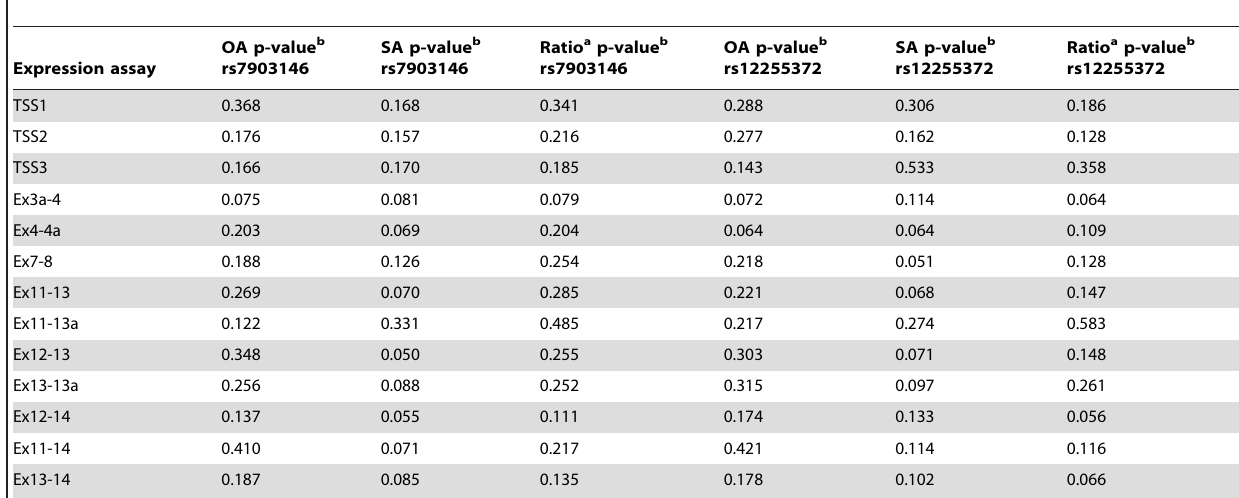
Table 3. Effect of presence 0, 1 or 2 risk alleles of TCF7L2 SNPs on expression of TCF7L2 in paired omental and subcutaneous adipose tissue samples, n =134.